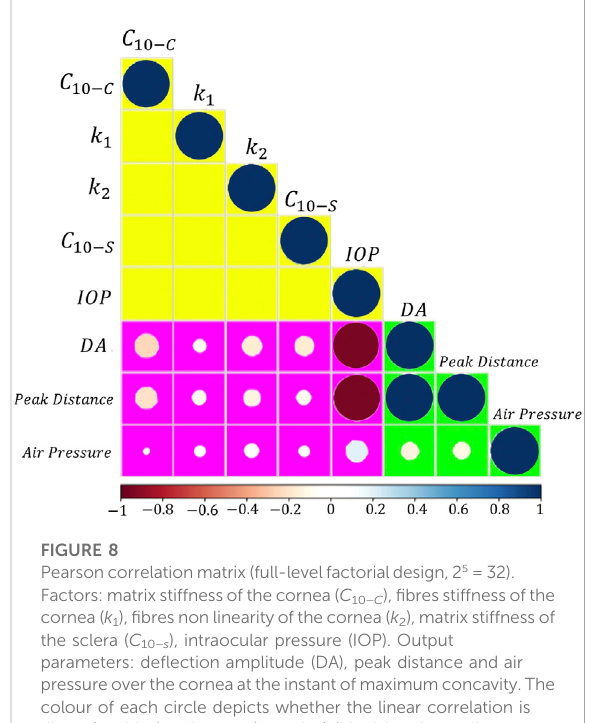
FIGURE 8 Pearsoncorrelationmatrix(full-levelfactorialdesign,2 5 =32). Factors:matrixstiffnessofthecornea( C 10 − C ), fi bresstiffnessofthe cornea( k 1 ), fi bresnonlinearityofthecornea( k 2 ),matrixstiffnessof the sclera ( C 10 − s ), intraocular pressure (IOP). Output parameters: de fl ection amplitude (DA), peak distance and air pressureoverthecorneaattheinstantofmaximumconcavity.The colour of each circle depicts whether the linear correlation is direct (positive) or inverse (negative) (blueish palette, direct; reddish palette, inverse). The larger the circle diameter, the higher the correlation.